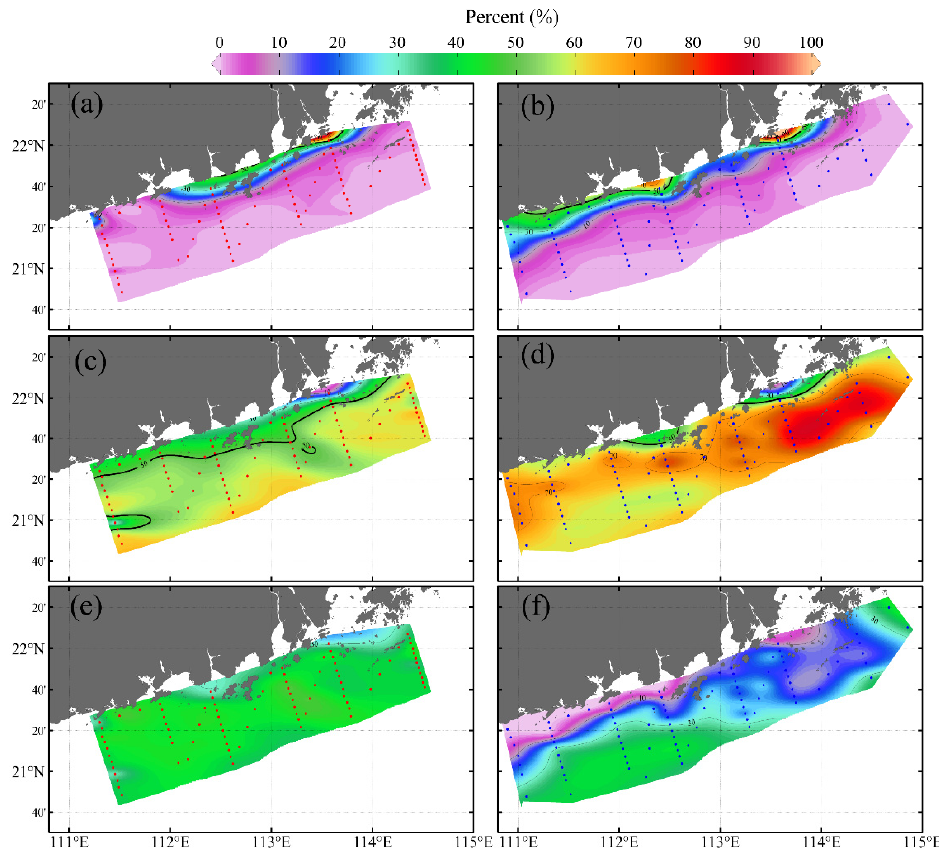
Figure 5. Water mass contributions (%) of PRDW ( a , b ), SCSSW ( c , d ) and SCSSUW ( e , f ) in the bottom layer for the April ( a , c , e ) and May ( b , d , f ) cruises.